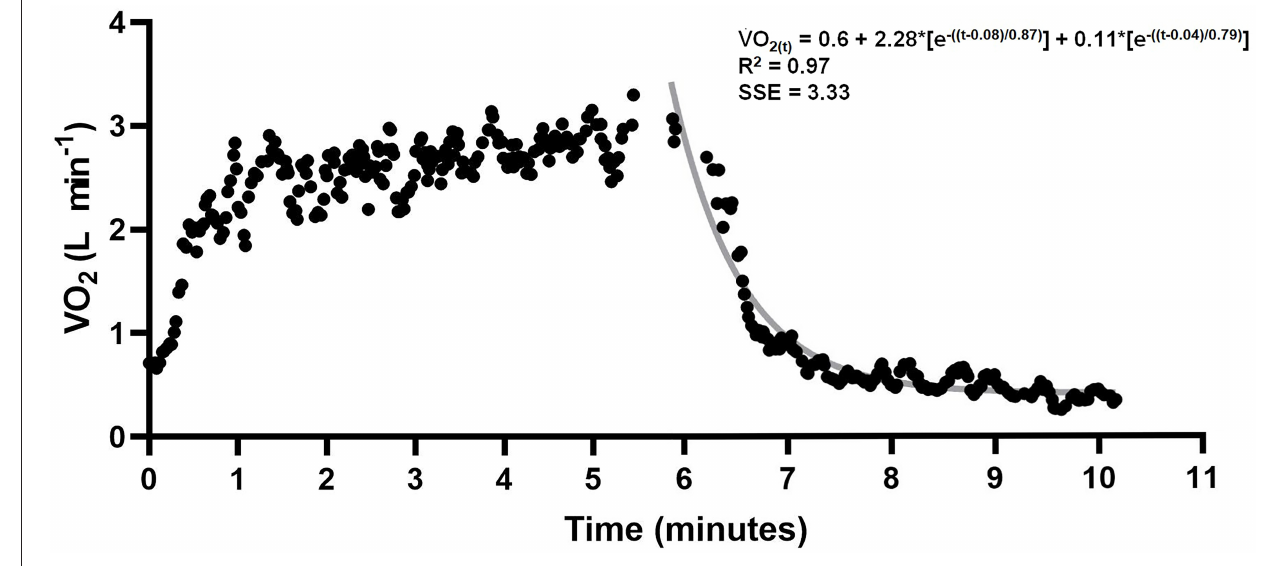
FIGURE 2 | VO 2 data from 400m swimming and recovery. Gray line indicates bi-exponential adjustment. Alactic anaerobic contribution was assumed as the product between A1 and t 1